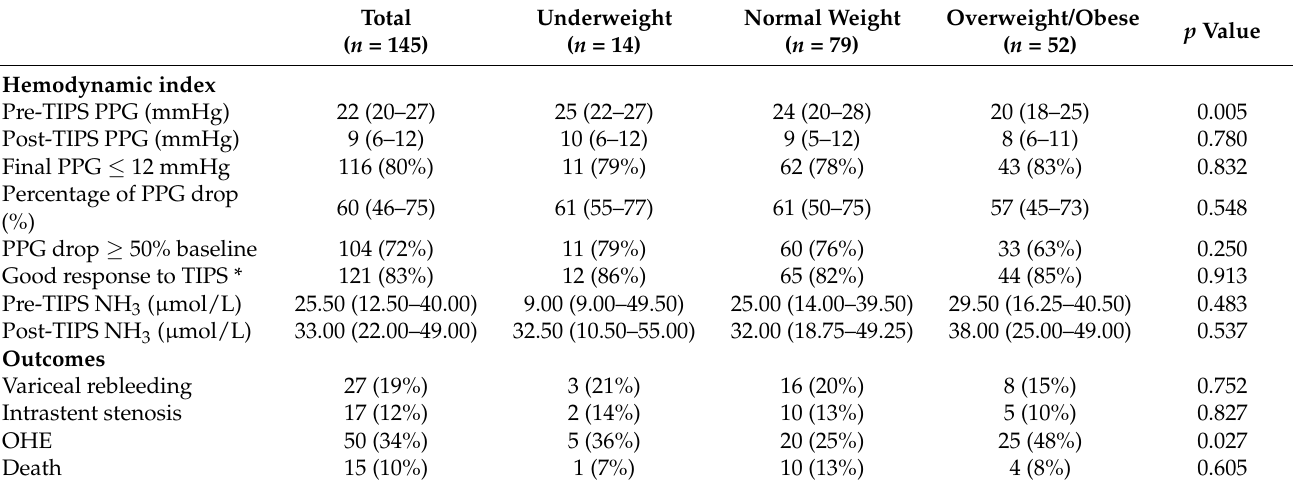
Table 2. Hemodynamic index and clinical outcomes according to BMI subgroup